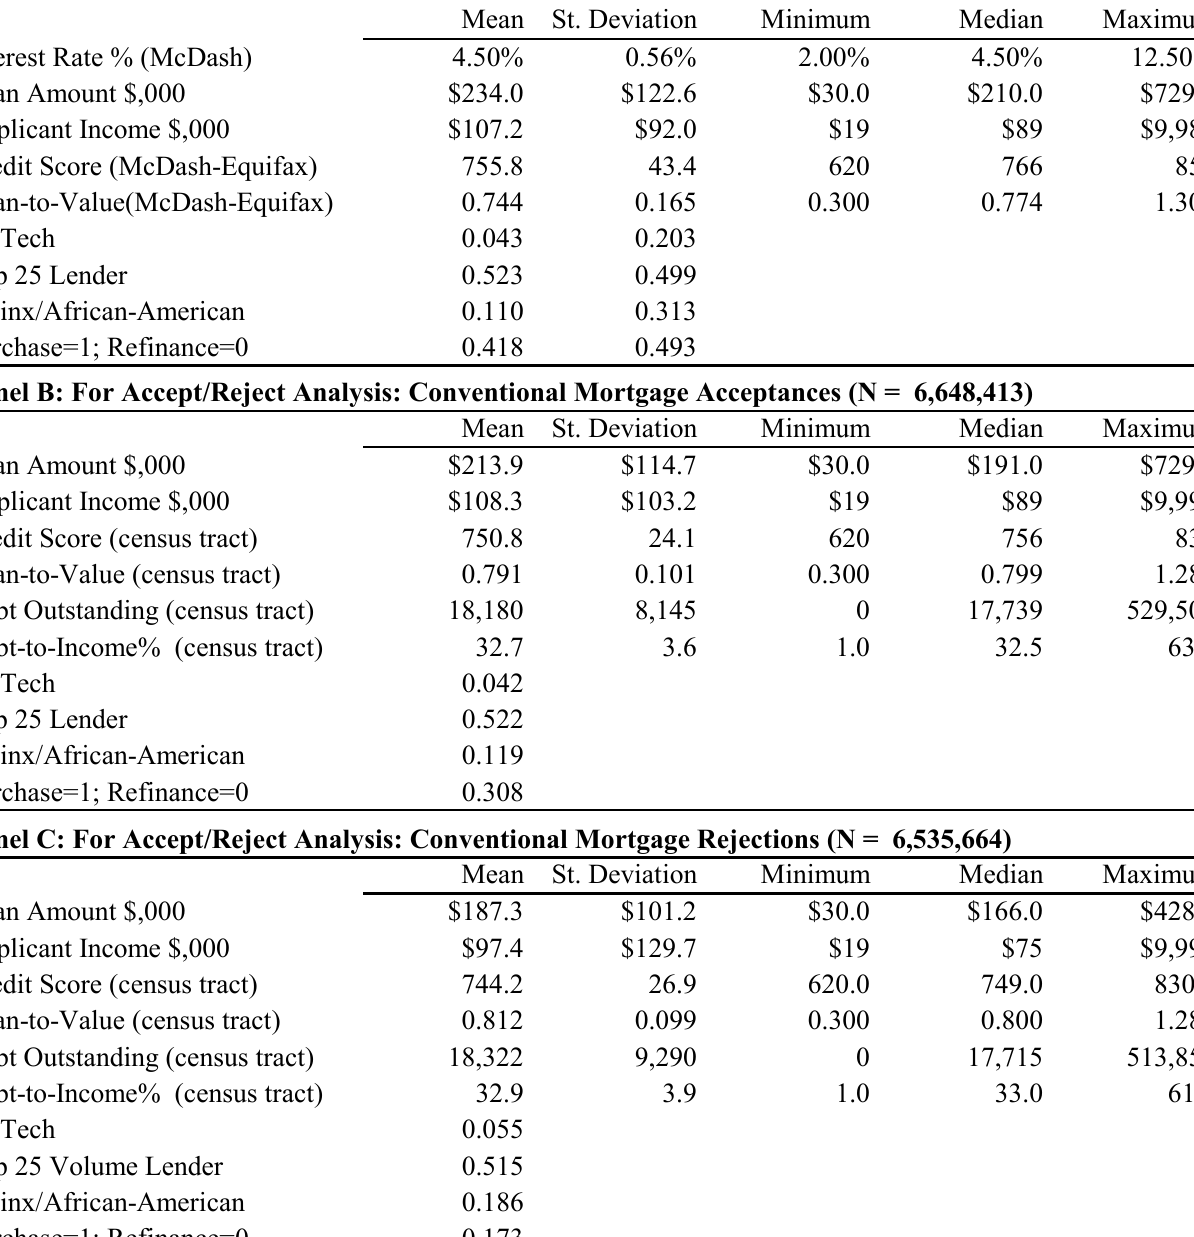
Panel A: For Pricing Analysis: GSE, 30-Year Fixed Rate Mortgage Acceptances (N =